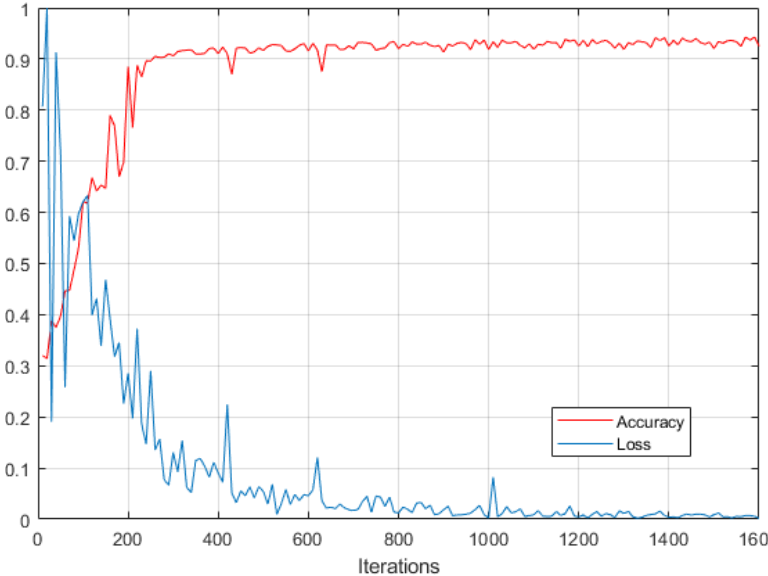
Figure 16. Nodule detection accuracy and loss over the training process of the proposed